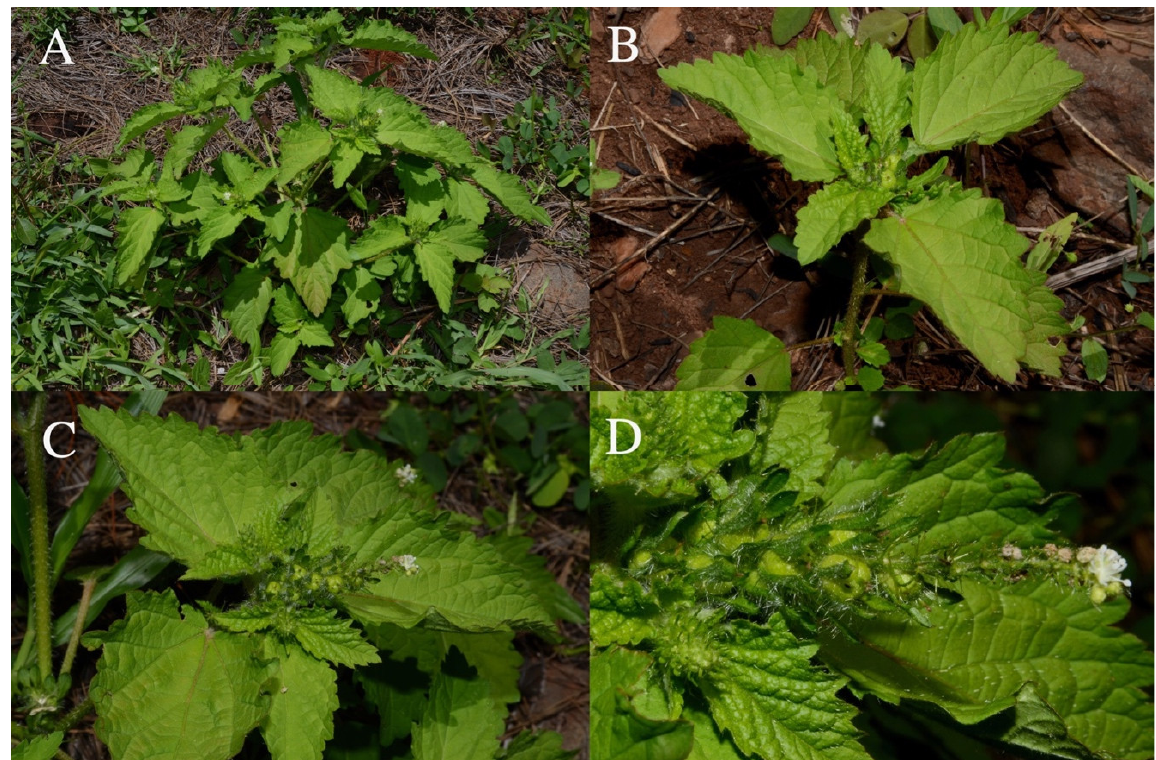
Figure A10. Croton hirtus. ( A , B ) Habit. ( C ) Flowering branch. ( D ) Inflorescence.